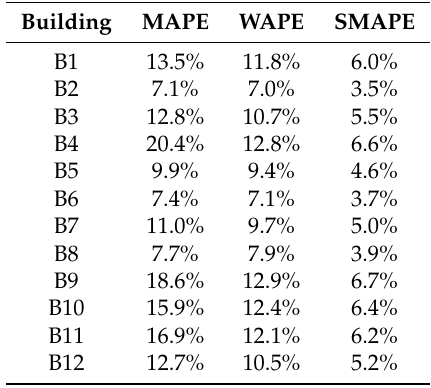
Table 2. Prediction error for each building: artificial neural network model, time frame: 5–10 p.m.